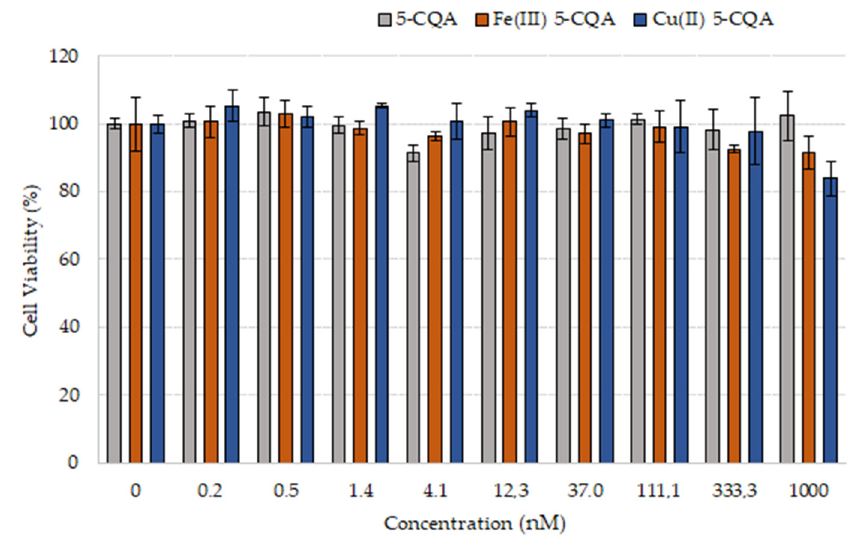
Figure 13. Viability of HaCaT cells after treatment with 5-CQA and its complexes with Fe(III) and Cu(II) (C = 0.15–1000 nM) for 24 h.